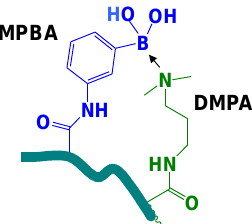
Figure 3. Interaction (dative bond) between PBA moiety and amine group in N,N’-3- dimethylamino-propylmethacrylamide (DMP) near pH